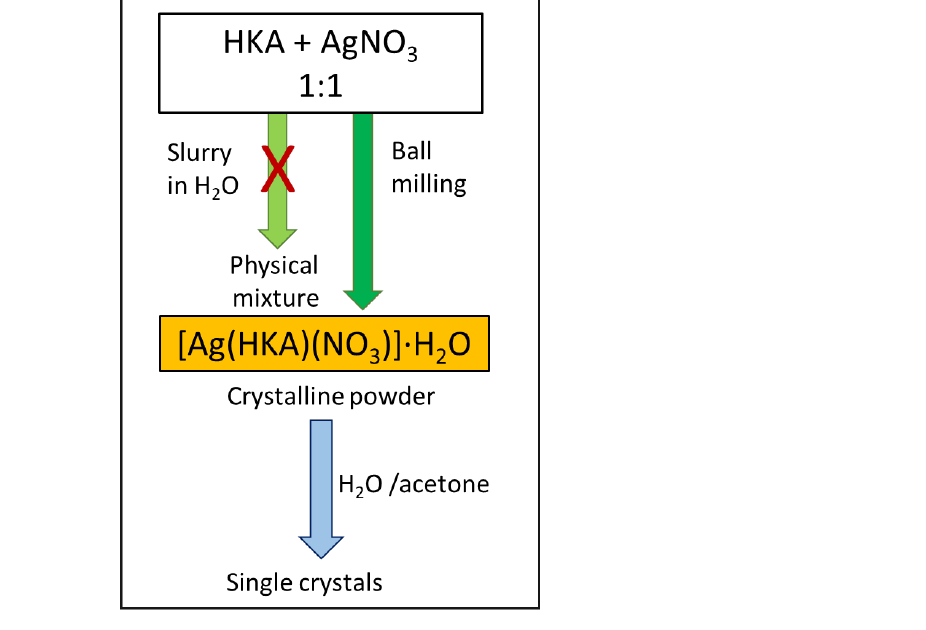
Scheme 3. Details of the slurry, ball milling, and crystallization processes for the preparation of [Ag(HKA)(NO 3 )]∙H 2 O.